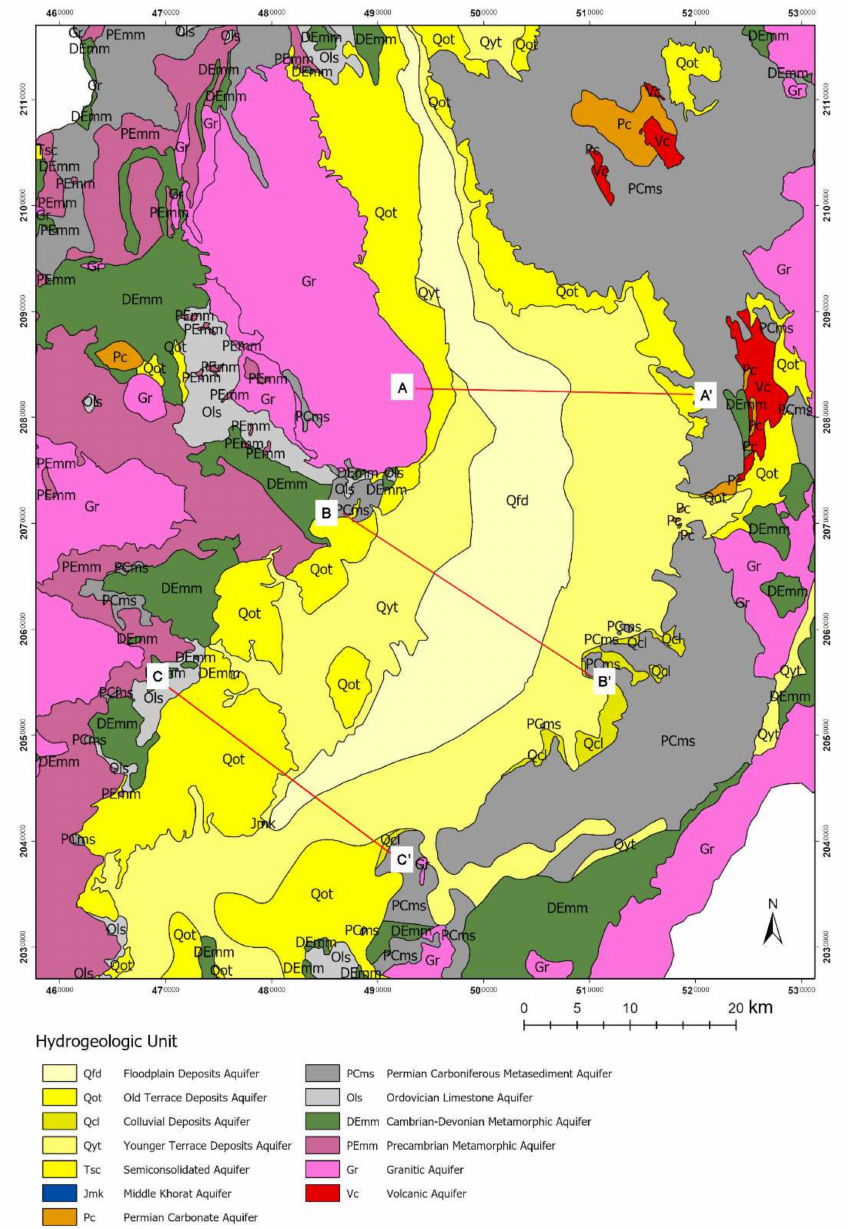
Figure 2. Hydrogeologic units of the Chiang Mai basin (modified from Reference [12]), overlain by model grids used in groundwater flow